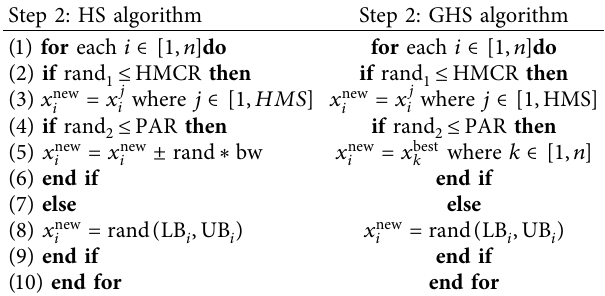
Table 1: Comparison of the improvisation step in HS and GHS. Step 2: HS algorithm Step 2: GHS algorithm